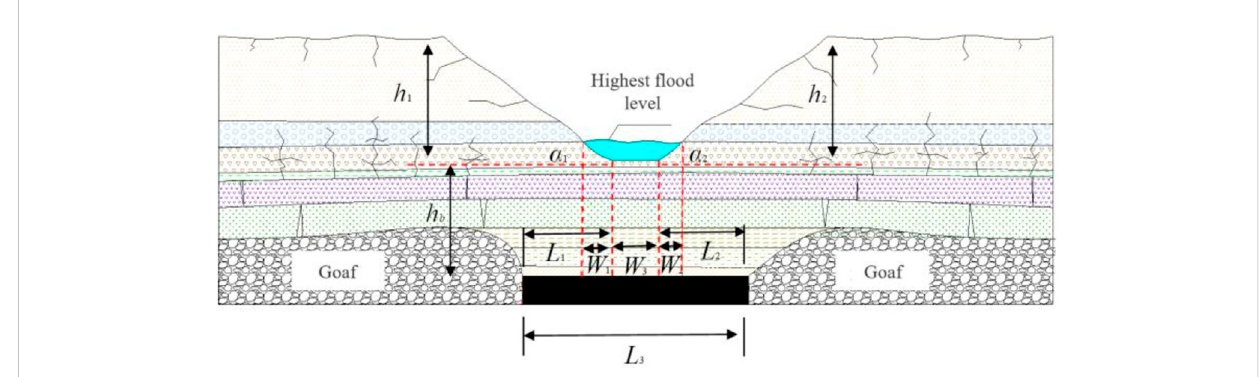
FIGURE 13 Generalization Model of safety coal pillar for Mining under Slope.